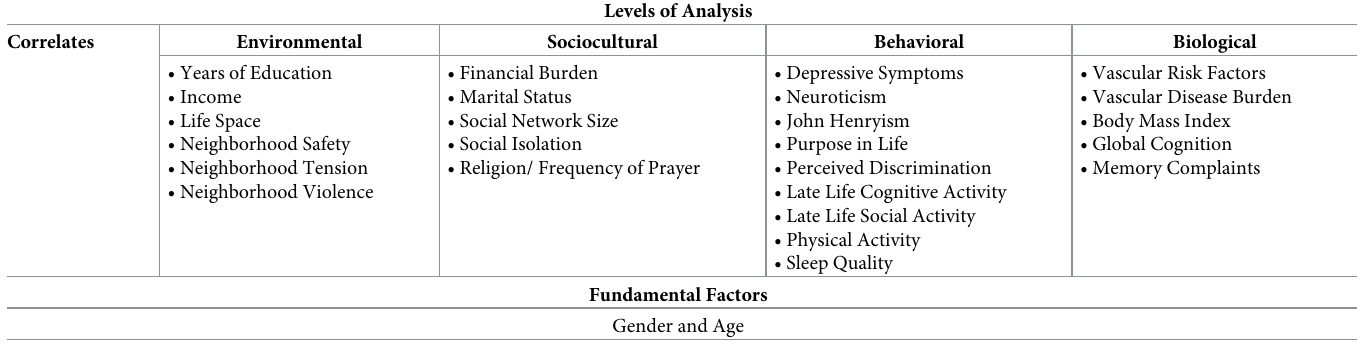
Table 1. Potential correlates of perceived stress among older African Americans by level of analysis �